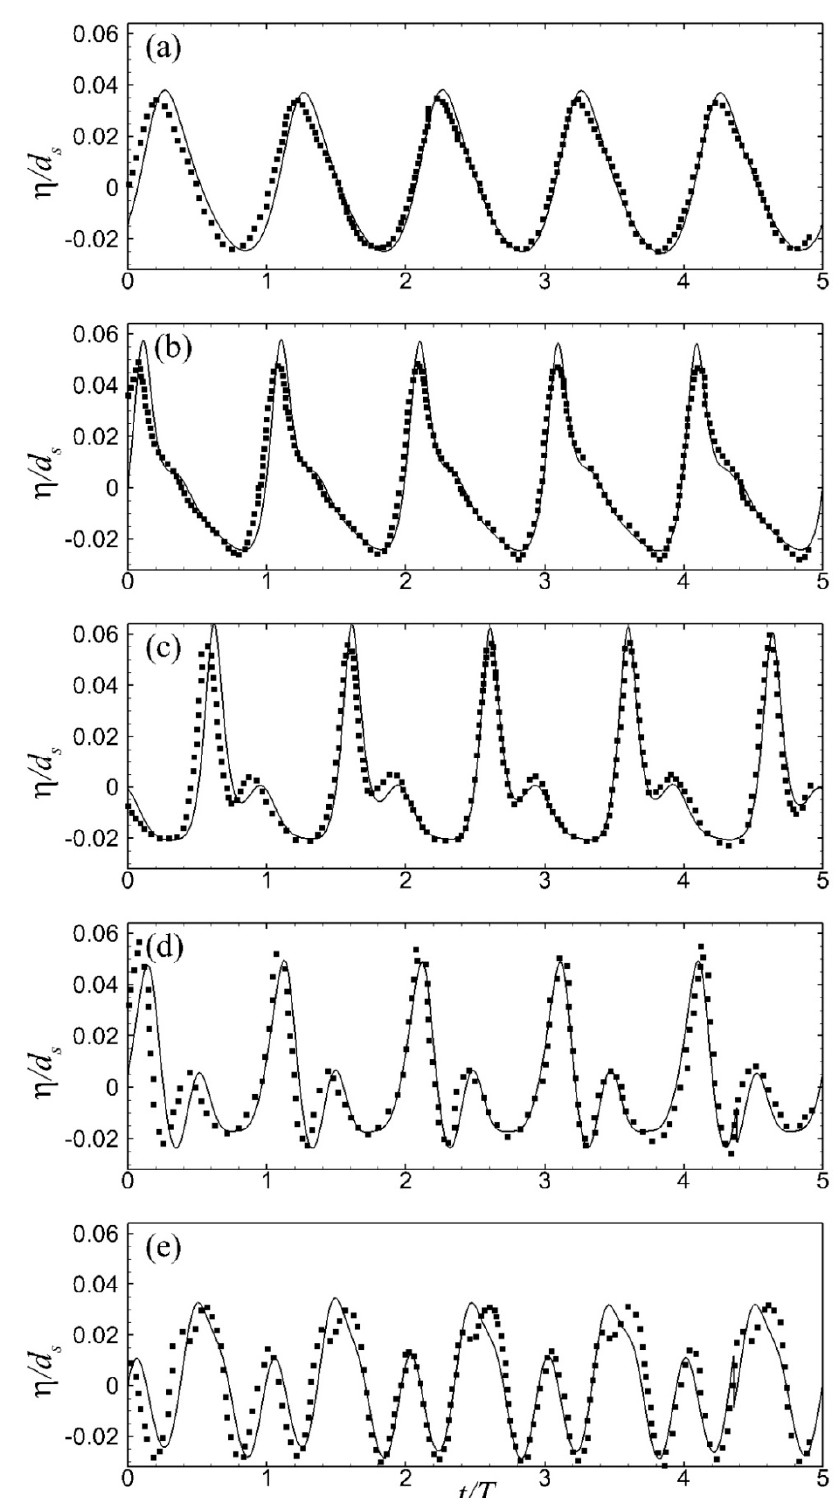
Figure 2. Variation of the free-surface elevation during five wave periods, after 20 wave periods of simulation, at five locations over a submerged impermeable trapezoidal bar. These five locations correspond, respectively, to the stations 2, 3, 4, 5, and 6 of Figure 1. The lines correspond to the present numerical results while the symbols to the experiments in [27]. The r.m.s. (root mean square) relative error of the free-surface elevation between numerical results and experimental data is: ( a ) 0.09, ( b ) 0.13, ( c ) 0.16, ( d ) 0.19, and ( e ) 0.18.